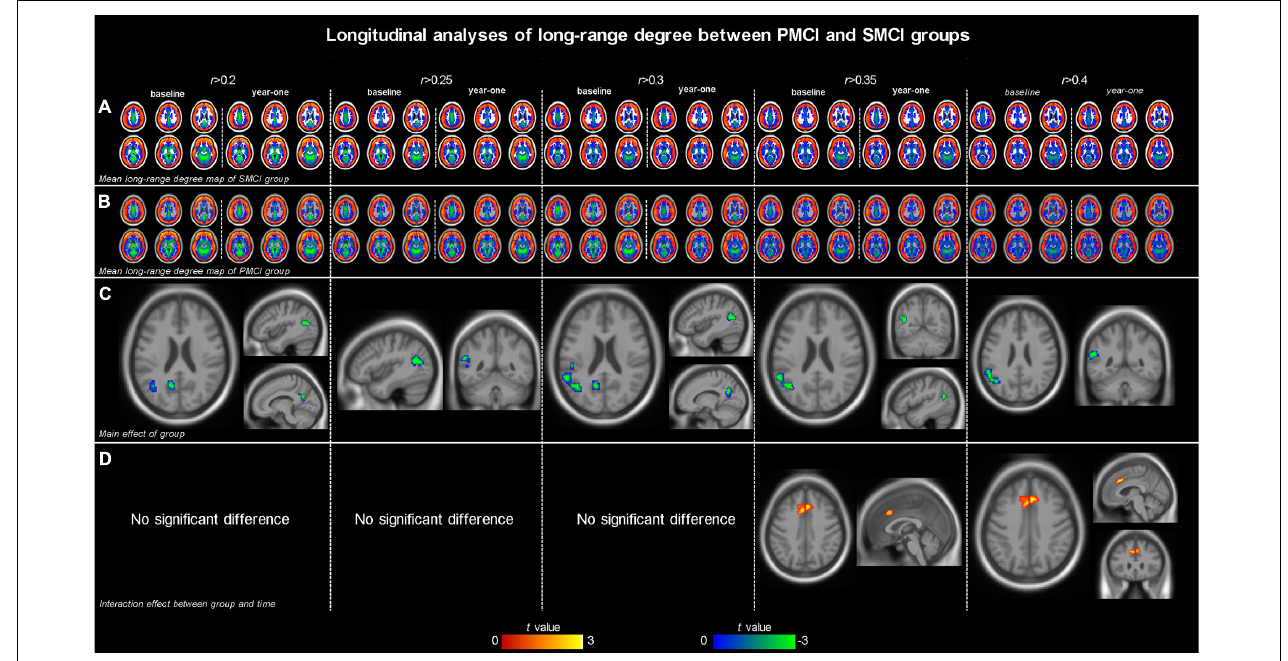
FIGURE 1 | The mean long-range degree maps of progressive mild cognitive impairment (PMCI) group and stable MCI (SMCI) group and the longitudinal analyses results across the correlation threshold range of 0.2–0.4. In row (A,B) , the mean long-range degree maps of SMCI and PMCI groups at baseline and year-one are shown, respectively. In row (C) , the green-blue indicates brain regions with significantly decreased long-range degree in PMCI group compared with SMCI group (controlling for the effect of time). In row (D) , the yellow–red indicates brain regions with a significant longitudinal increase of long-range degree in the PMCI group in 1-year duration compared with SMCI group (Statistical level: p < 0.01 with a minimal cluster size of 54 voxels, which yields an Alphasim correction threshold of p <